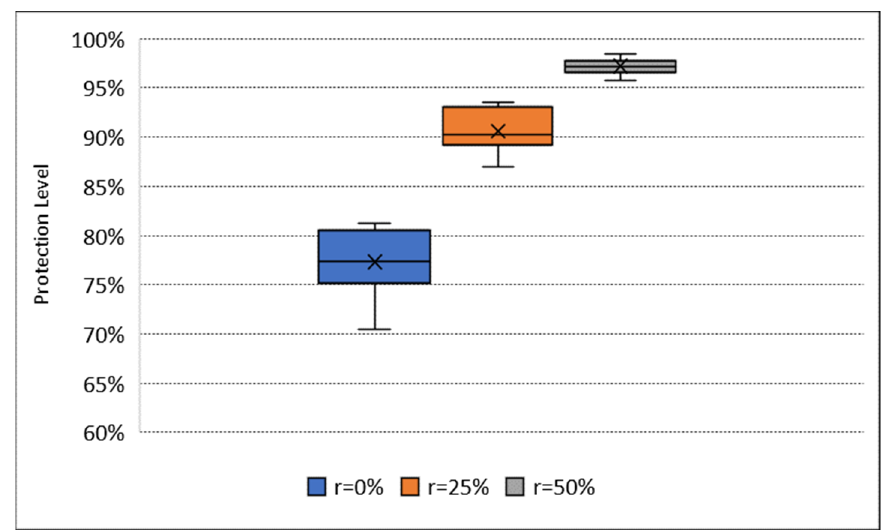
Figure 2. Protection levels for different values of 𝑟 across the considered countries.